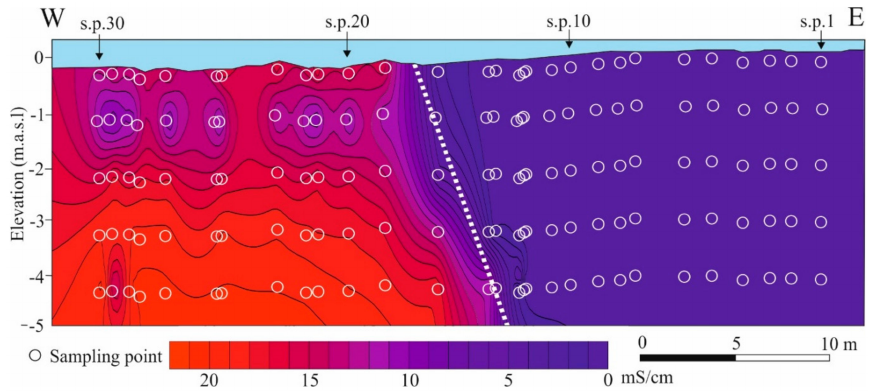
Figure 2. Interpolated electrical conductivity (EC) along the cross-section and sampling points (vertical scale × 2.5). The dashed line represents the transition from freshwater to saltwater. Sampling points are located with empty circles, and the locations of sampling points 1, 10, 20 and 30 are